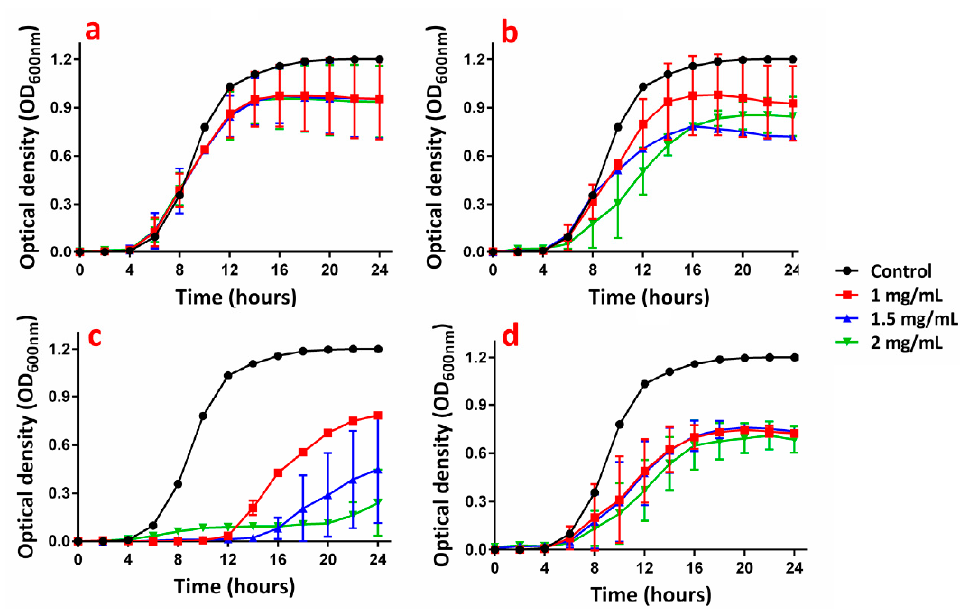
Figure 19. Growth curves of the nanocomposites D with the ratios ( 1 ) ( a ), ( 2 ) ( b ), ( 3 ) ( c ), and ( 4 ) ( d ) at various concentrations against S. aureus .